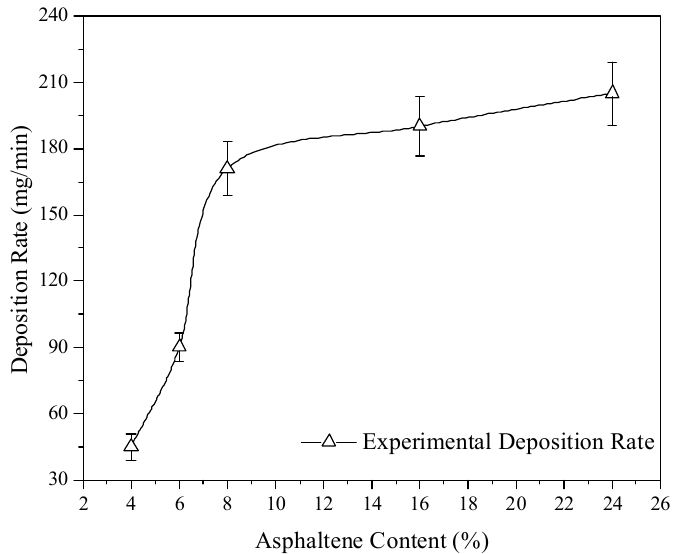
Table 4. Analysis of the compositions of solid particle emissions. Figure 10. Comparison of the deposition rate of HFO with different asphaltene contents.